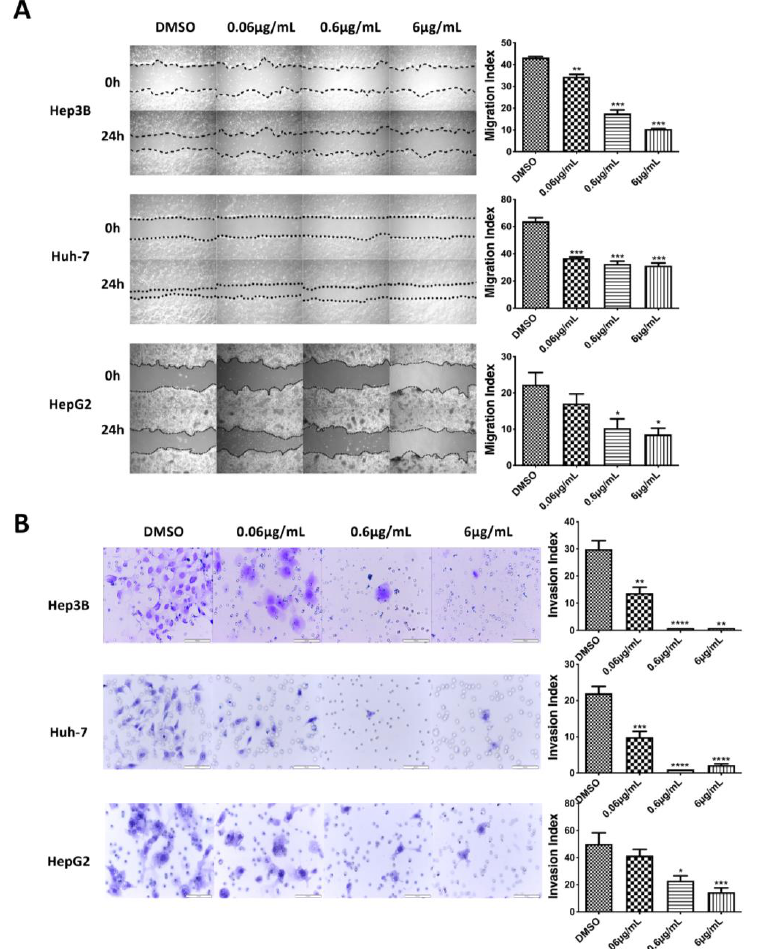
Figure 2. Inhibition of migration and invasion in haprolid-treated HCC cells. ( A ) Wound healing assay was performed for Hep3B, Huh-7 and HepG2 cells after haprolid (0.06, 0.6 and 6 µ g / mL) treatment. The dotted lines represent edges of the wound. Photographs were taken at 0 and 24 h under light microscope (40 × magnification). The migration index was calculated as described in Section 2 and plotted in bar graphs. ( B ) HCC cells were seeded in Matrigel transwell invasion chambers and treated with indicated concentrations of haprolid for 48 h to investigate the e ff ect on invasiveness. The number of cells that invaded through the membrane was determined under light microscope (200 × magnification). Scale bars: 100 µ m. Invasion index was calculated as described in Section 2 and plotted in bar graphs. Data represent means ± SEM of at least three independent experiments. * p < 0.05, ** p < 0.01, *** p < 0.001, **** p <